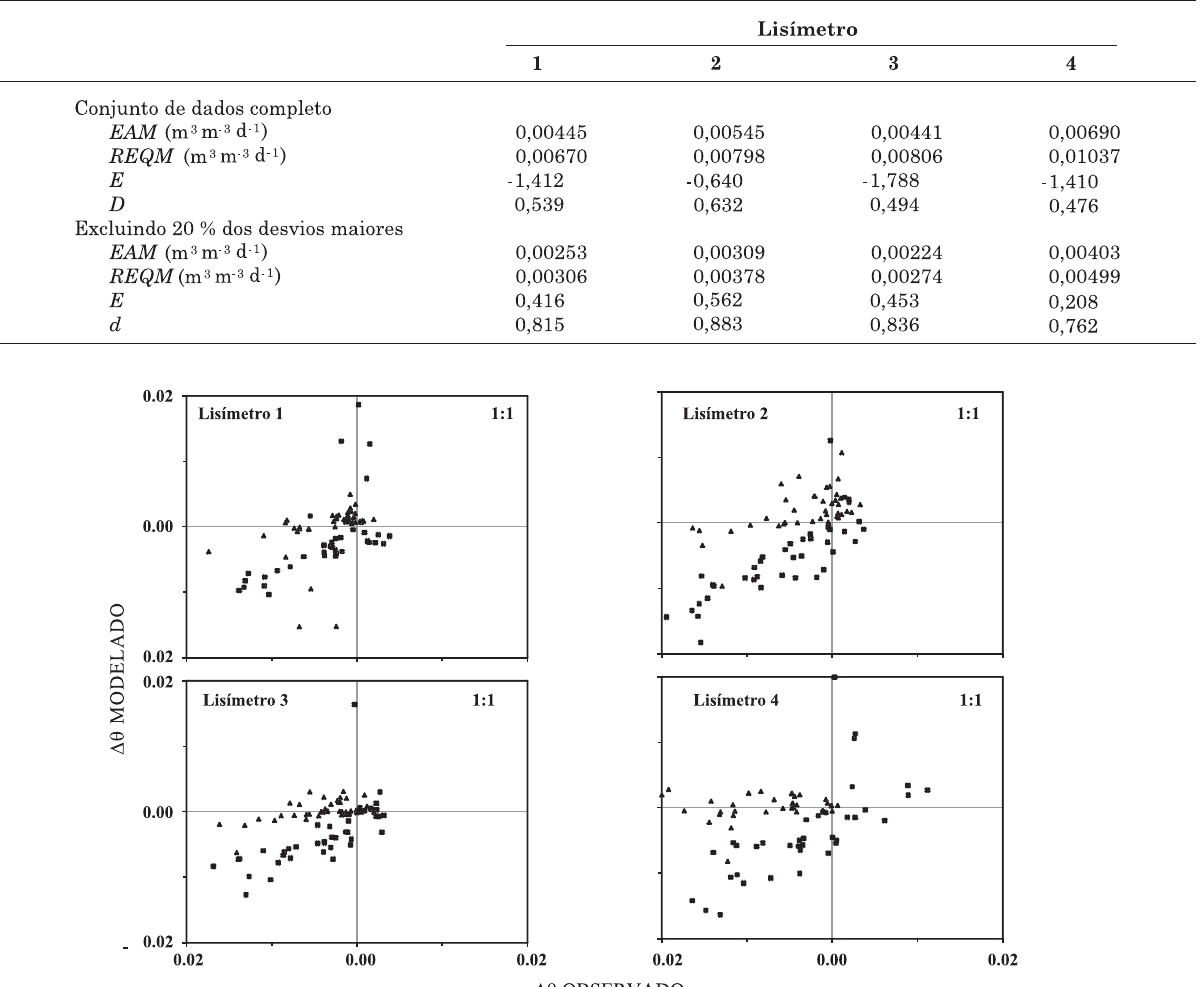
Figura 7. Valores de ΔθΔθΔθΔθΔθ observados e obtidos pelo modelo nos lisímetros 1, 2, 3 e 4. Quadrados e triângulos representam observações nos solos arenoso (AR) e argiloso (AG),